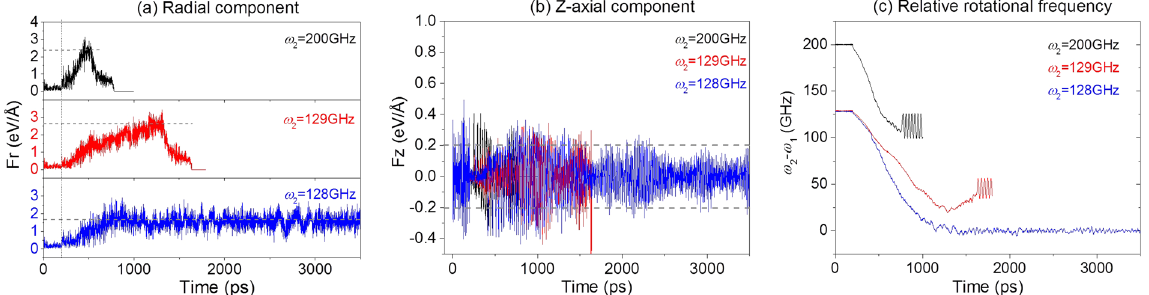
Figure 5. Comparisons of the radial centrifugal force, axial force of Rotor1 (17, 11), and relative rotational frequency between both rotors when driven by Rotor2 with different values of ω 2